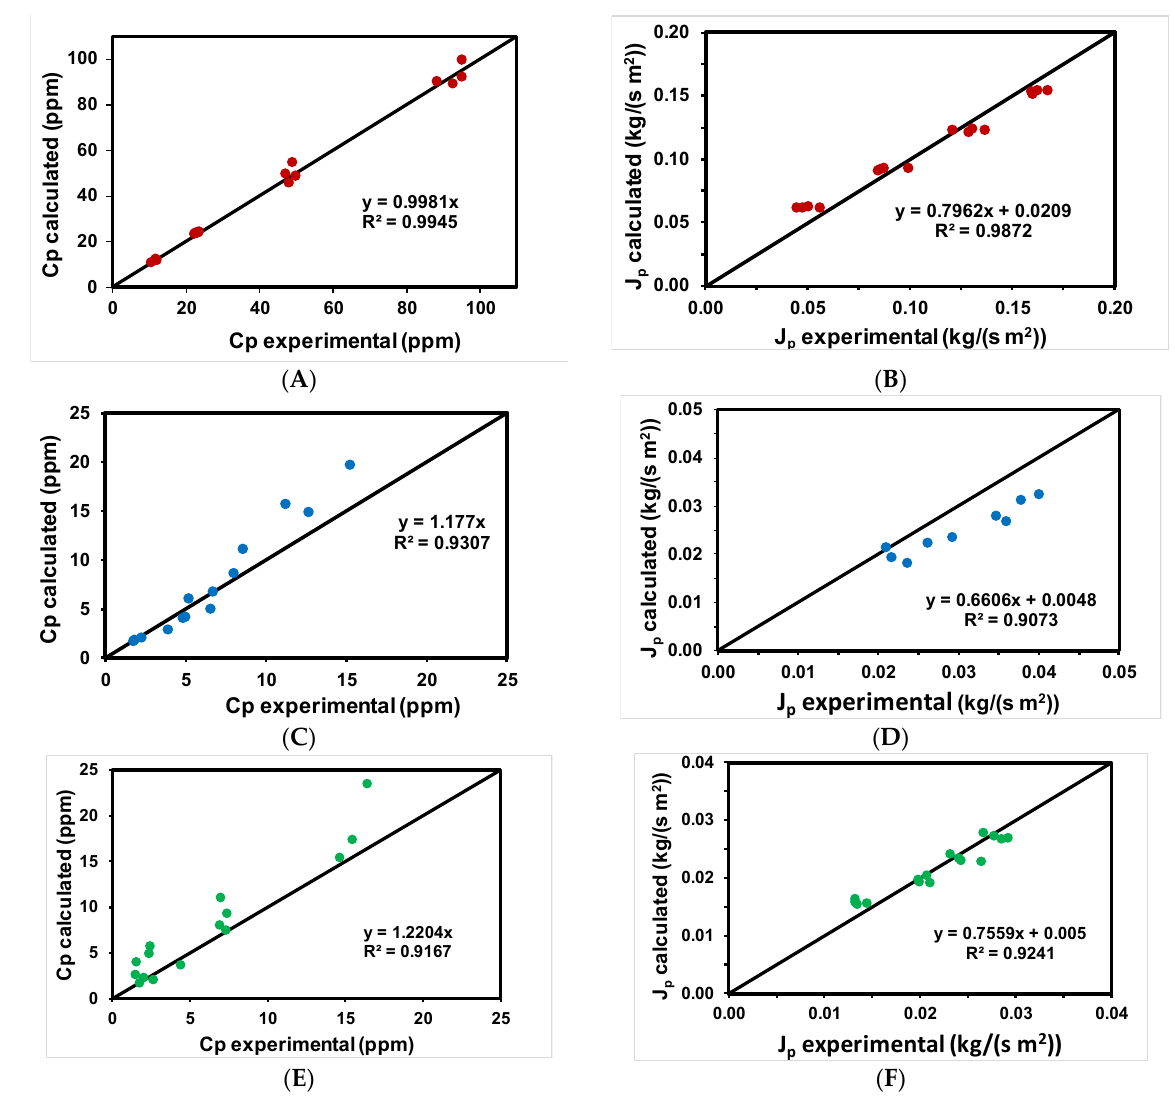
Figure 5. Experimental data of rejection coefficients and permeate fluxes versus those calculated with the solution-diffusion model for the different membranes tested for the removal of methyl paraben: (●) NF99HF, (●) RO90, and (●) RO99.